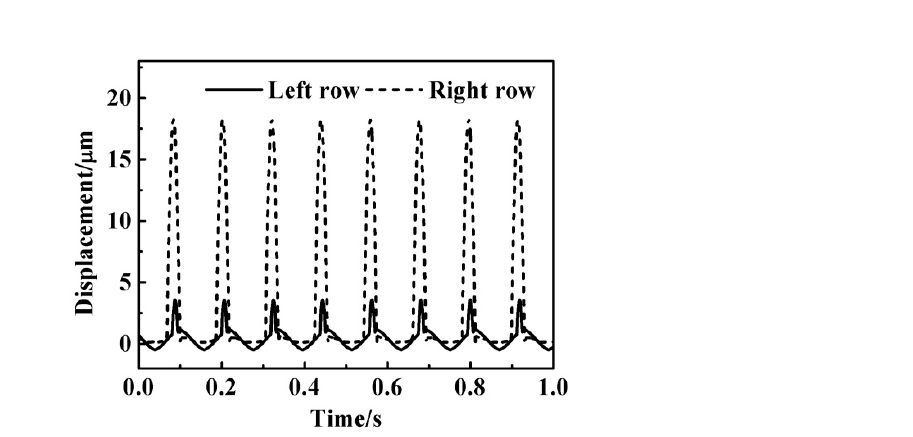
Figure 19. The normal displacements of two-row rollers under the same operating condition are shown in Figure 18d.